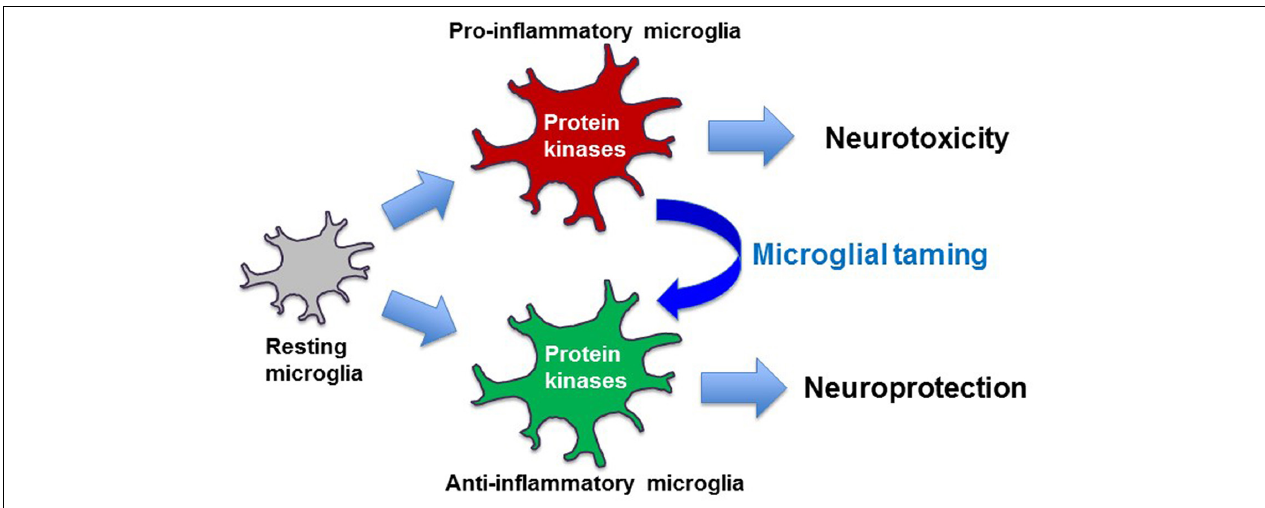
FIGURE 2 | Taming of microglia toward disease-modifying therapy. Pro-inflammatory microglia exert neurotoxic effects, while anti-inflammatory microglia are often neurotrophic and neuroprotective. Protein kinase-based modulation of microglial phenotypes from pro-inflammatory to anti-inflammatory may form the basis of disease-modifying